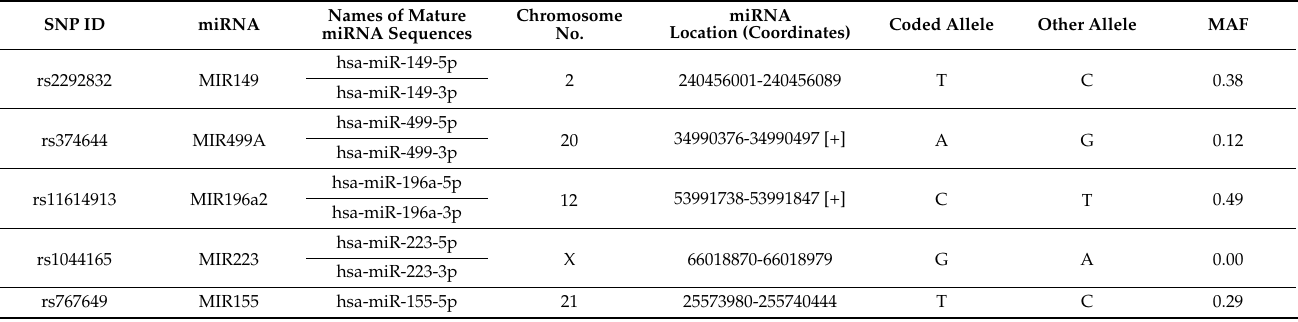
Table 2. Detailed information regarding the miRNAs.